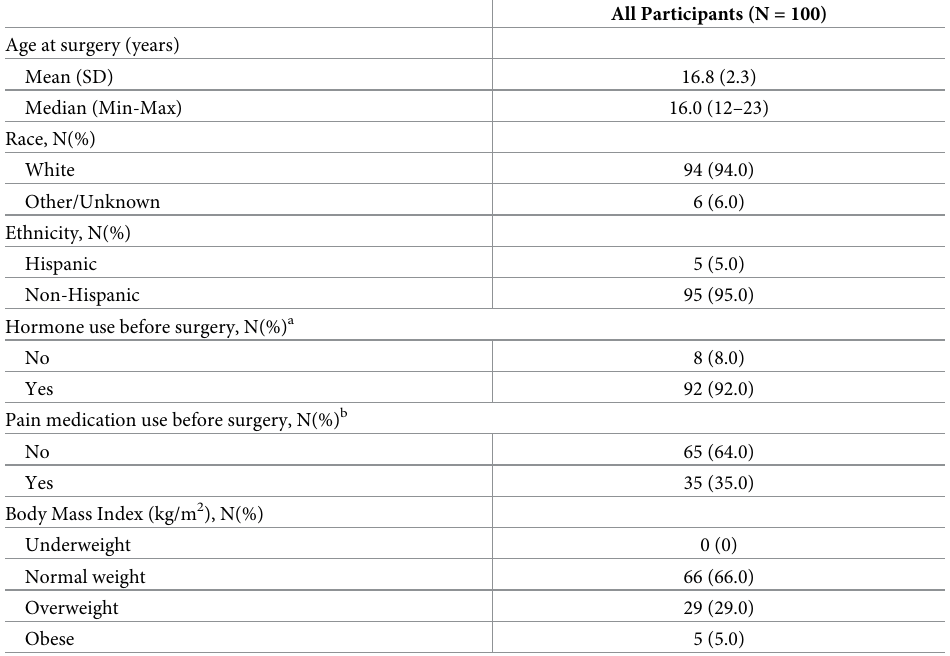
Table 1. Pre-surgery (at enrollment) demographics of EndoQUEST